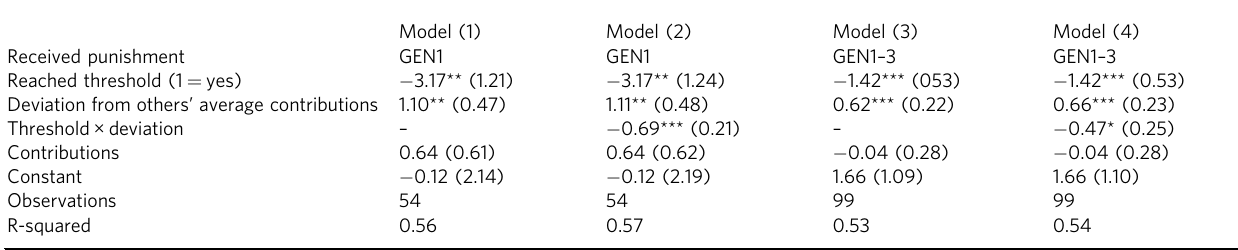
Table 1 Determinants of receiving